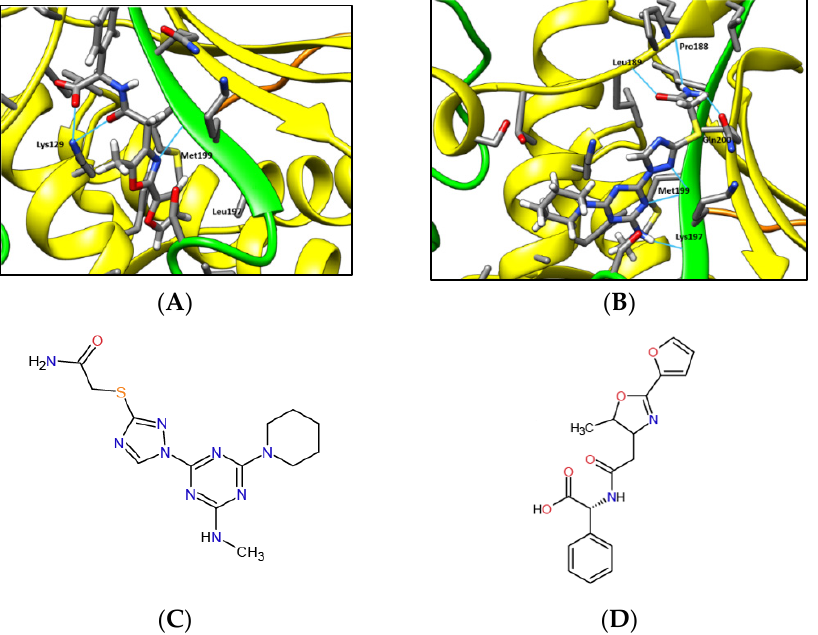
Figure 2. Small molecules docked in the cavity of the MAD2L2 dimer. The coloring scheme for MAD2L2 follows that of Figure 1. Molecules are shown using stick representation. ( A ) The small molecule ZINC97017995 (c#2) docked in the cavity of the MAD2L2 dimer. Met199 and Leu197 form Van der Waals or hydrophobic interactions with ZINC97017995. Lys129 forms two hydrogen bonds with the molecule. Met199 forms one hydrogen bond through its backbone. Hydrogen bonds are marked with a cyan line. ( B ) The small molecule ZINC25496030 (c#3) docked in the cavity of the MAD2L2 dimer. Met199 forms two hydrogen bonds with ZINC25496030. Pro188, Leu189, Lys197, and Gln200 each form one hydrogen bond with the molecule. ( C ) Two-dimensional drawing of ZINC97017995 (c#2). ( D ) Two-dimensional drawing of ZINC25496030